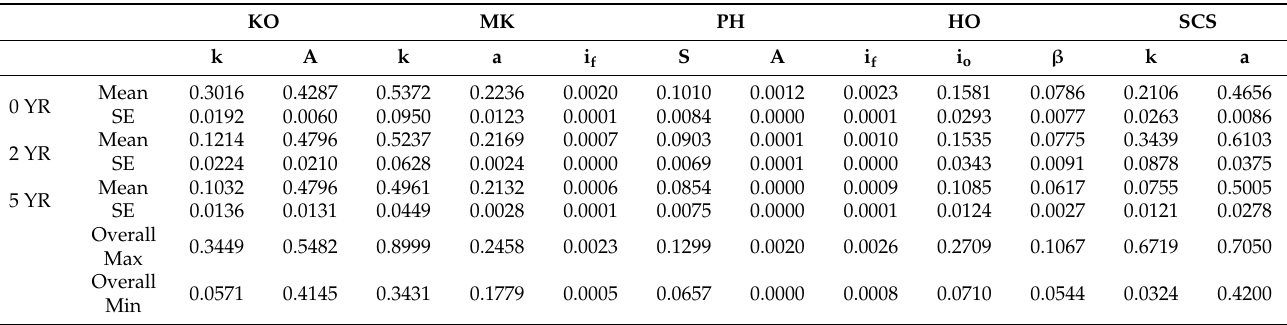
Table 3. The estimated parameters of the five evaluated soil infiltration models for TWW irrigated soils at